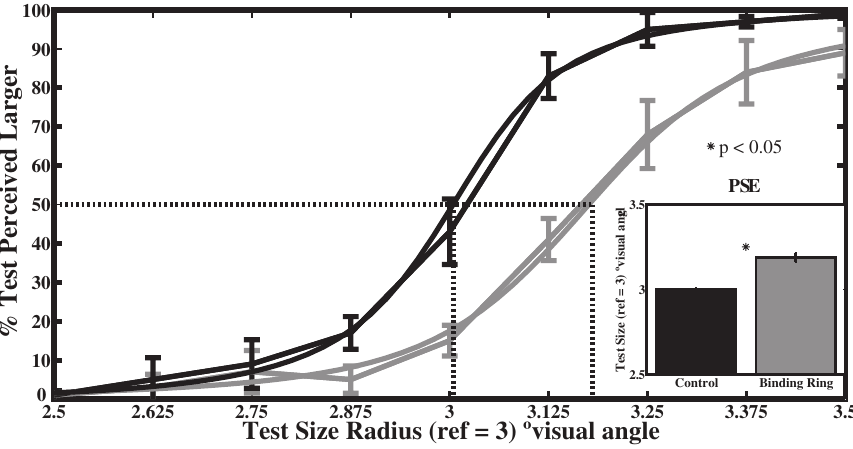
Figure 4. Results of experiment 1. Psychometric curves indicate the mean fit of the data averaged across all participants. The inset of the figure illustrates the mean points of subjective equality (PSEs) for the test and reference stimuli. The black curve indicates that participants were accurately judging the radius of an unbound array. The grey curve shows that the array radius must increase by ~0.18° to be perceived as being the same size as an unbound array. Thick curves with error bars indicate the mean response across participants for each array radius. Thin curves indicate the function fitted to the data. Error bars represent standard error of the mean PSE computed across